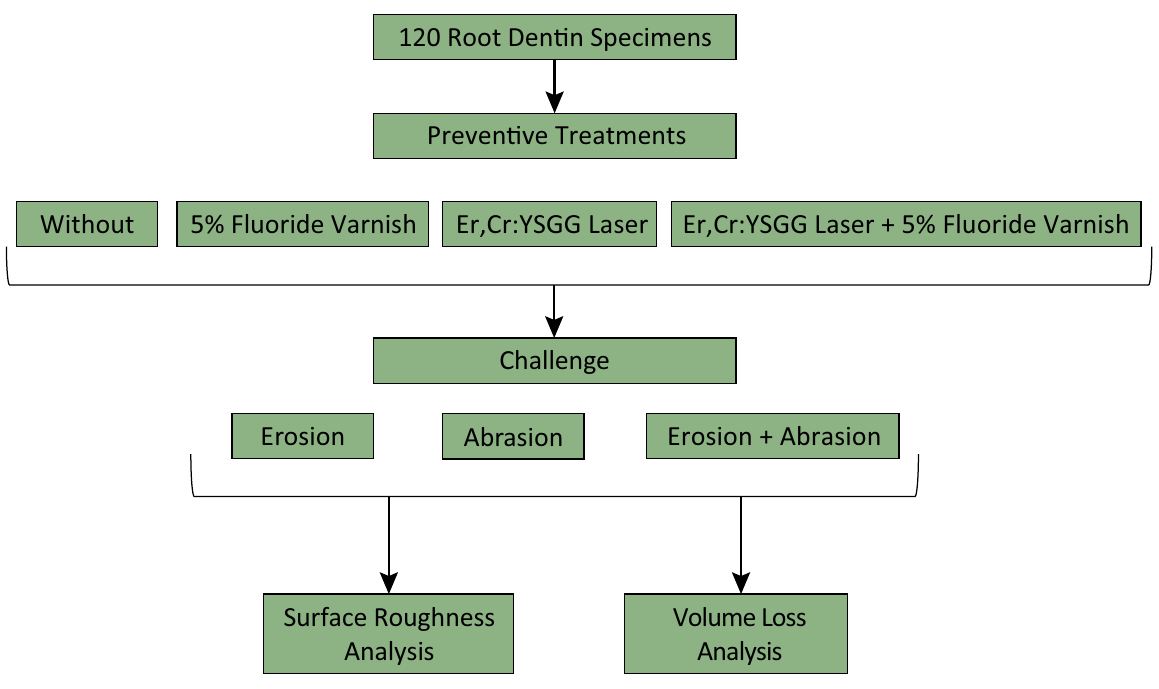
Figure 1. Flowchart of the